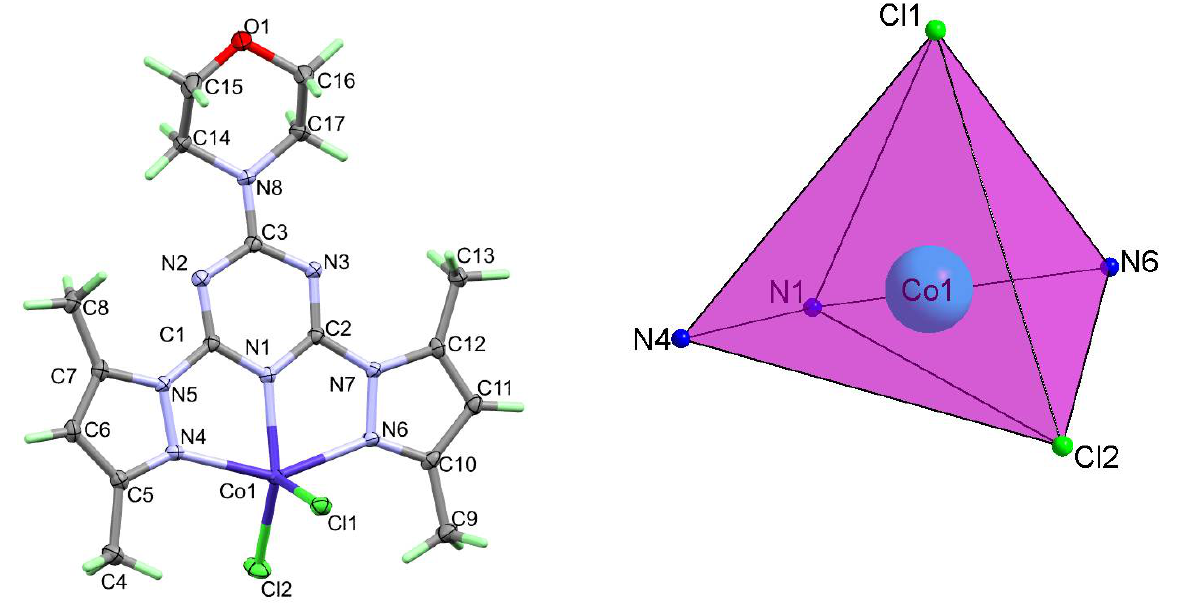
Figure 2. Structure with atom numbering (left) and the distorted square pyramidal (right) of 1 . Table 2. Bond lengths (Å) and angles ( ◦ ) for complexes 1 and 2 .